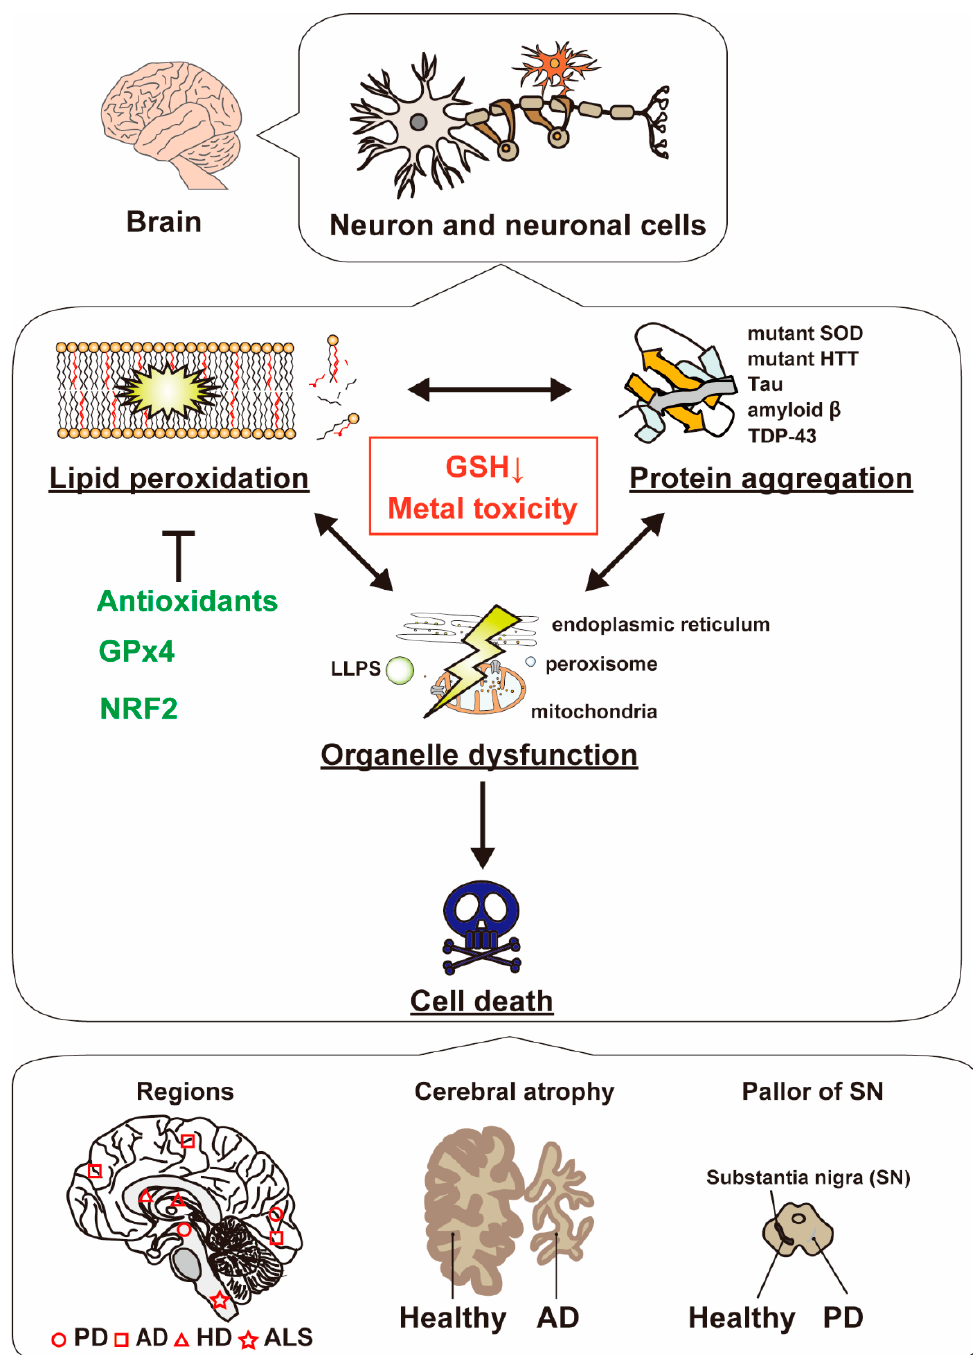
Figure 4. The molecular link between lipid peroxidation and protein aggregation in neurodegenerative diseases. Both lipid peroxidation and protein aggregation simultaneously occur in neuron and neuronal cells, leading to organelle dysfunction and cell death. ALS is a neurological disease characterized by progressive degeneration of nerve cells in the brain and spinal cord. Mutant superoxide dismutase 1 (SOD1) is expressed in a subgroup of familial ALS. Similarly, HD is caused by the huntingtin protein (HTT). The mutant proteins aggregate in the striatum of HD patients. In AD patients, tau fibrils and amyloid β aggregates are detected in the brain. Cerebral atrophy, which is the loss of cerebral brain cells, also occurs in AD patients. In PD, although α -synuclein is increased, the number and sizes of dopaminergic neurons are reduced in the substantia nigra. The bottom panel indicates major neurodegenerative diseases and their associated regions